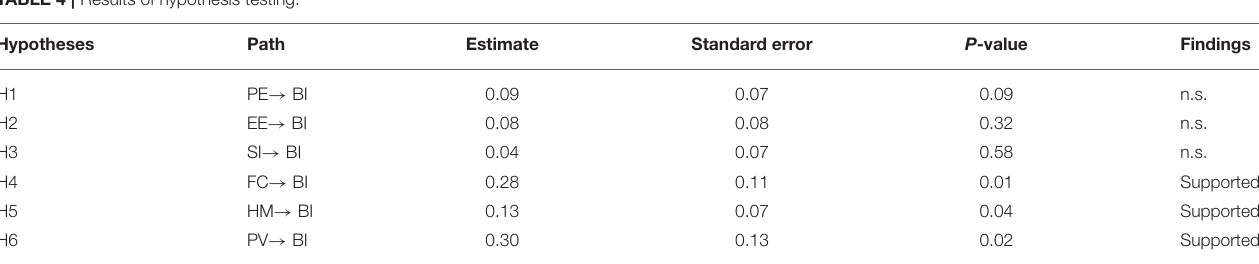
TABLE 4 | Results of hypothesis